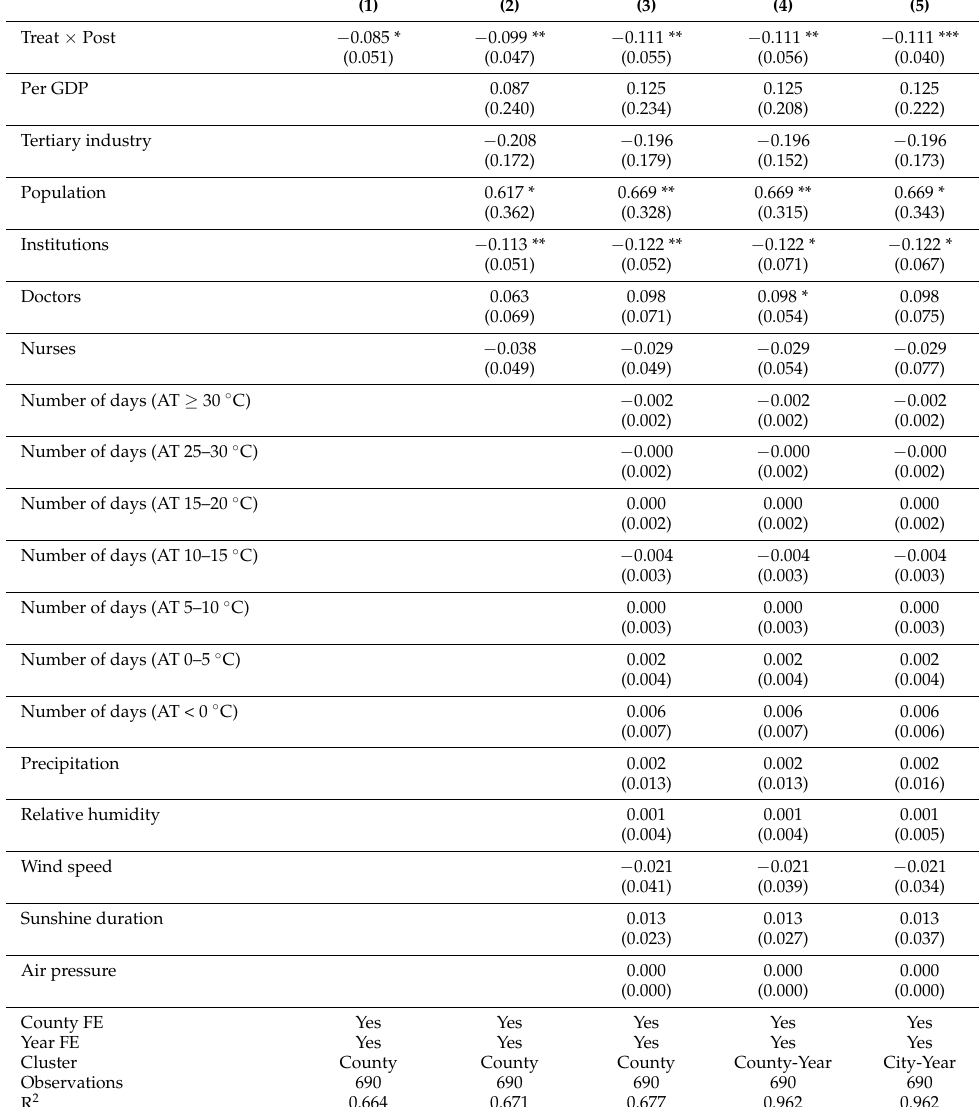
Table 2. Impact of the SPR on total medical expenses borne by the UURBMI and